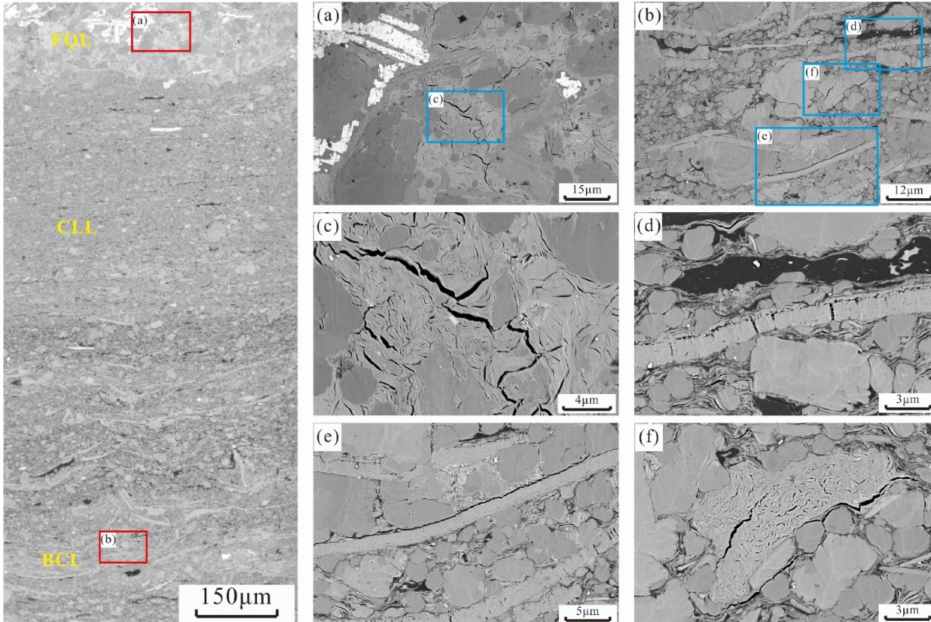
Figure 6. SEM images of FQL and BCL from Well G108-8 at 2936.73 m. ( a ) Magnification of FQL; ( b ) magnification of BCL; ( c ) intercrystalline pores of clay minerals in FQL; ( d ) intercrystalline pores of bioclastic in BCL; ( e ) edge gap of bioclastic in BCL; ( f ) intercrystalline pores of clay minerals in BCL. FQL: feldspar-quartz laminae; CLL: clay laminae; BCL: bioclastic